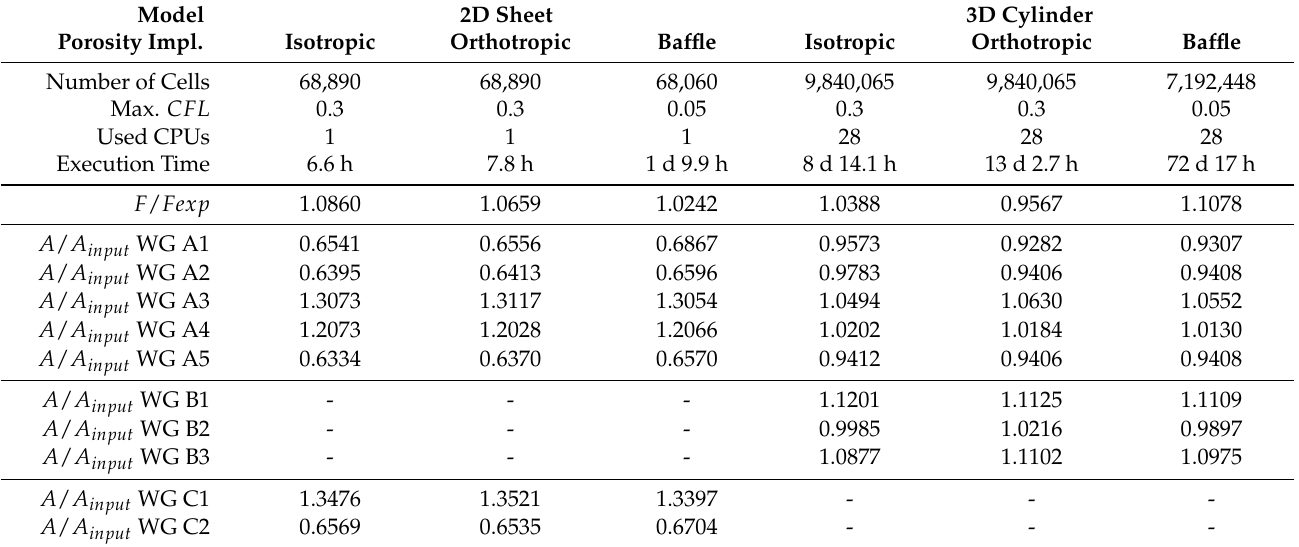
Table 2. Summary of the normalized mean force amplitude results, F / F exp , and the normalized mean wave amplitude results, A / A input at the WGs, including mesh cell number and execution times for all models. Model 2D Sheet 3D Cylinder Porosity